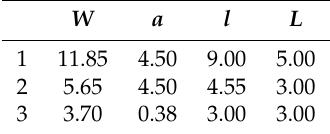
Table 1. Dimensions for three different SAW devices. Units: